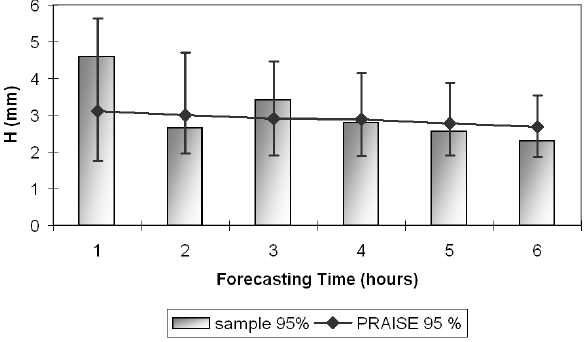
Fig. 6. Validation results for all tested events.